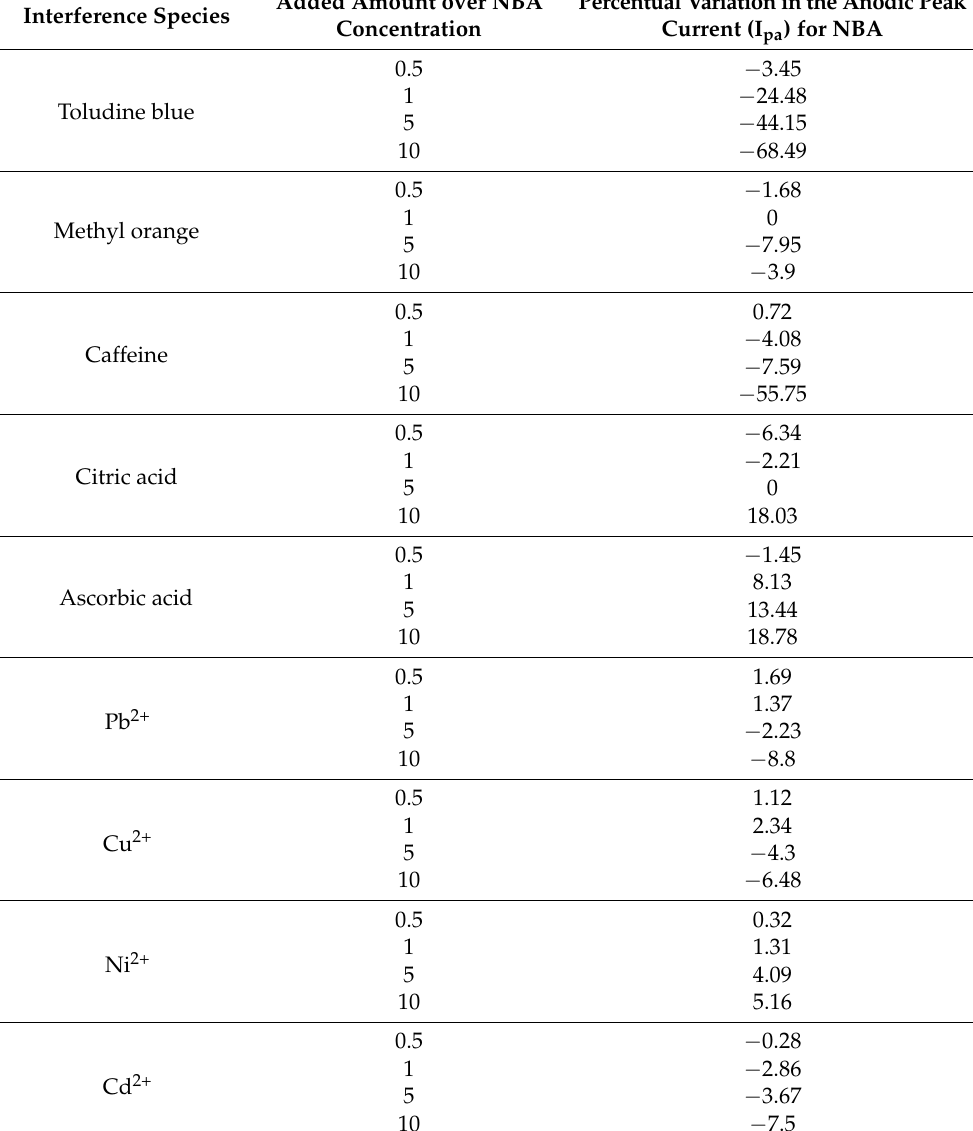
Table 4. Effect of some potential interference species on the response of the GCE/Lys/HA to 10 − 6 mol · L − 1 NBA in 0.1 M PBS (at pH 8). Added Amount over NBA Percentual Variation in the Anodic Peak Interference Species Concentration Current (I pa ) for NBA 0.5 − 3.45 − Toludine blue